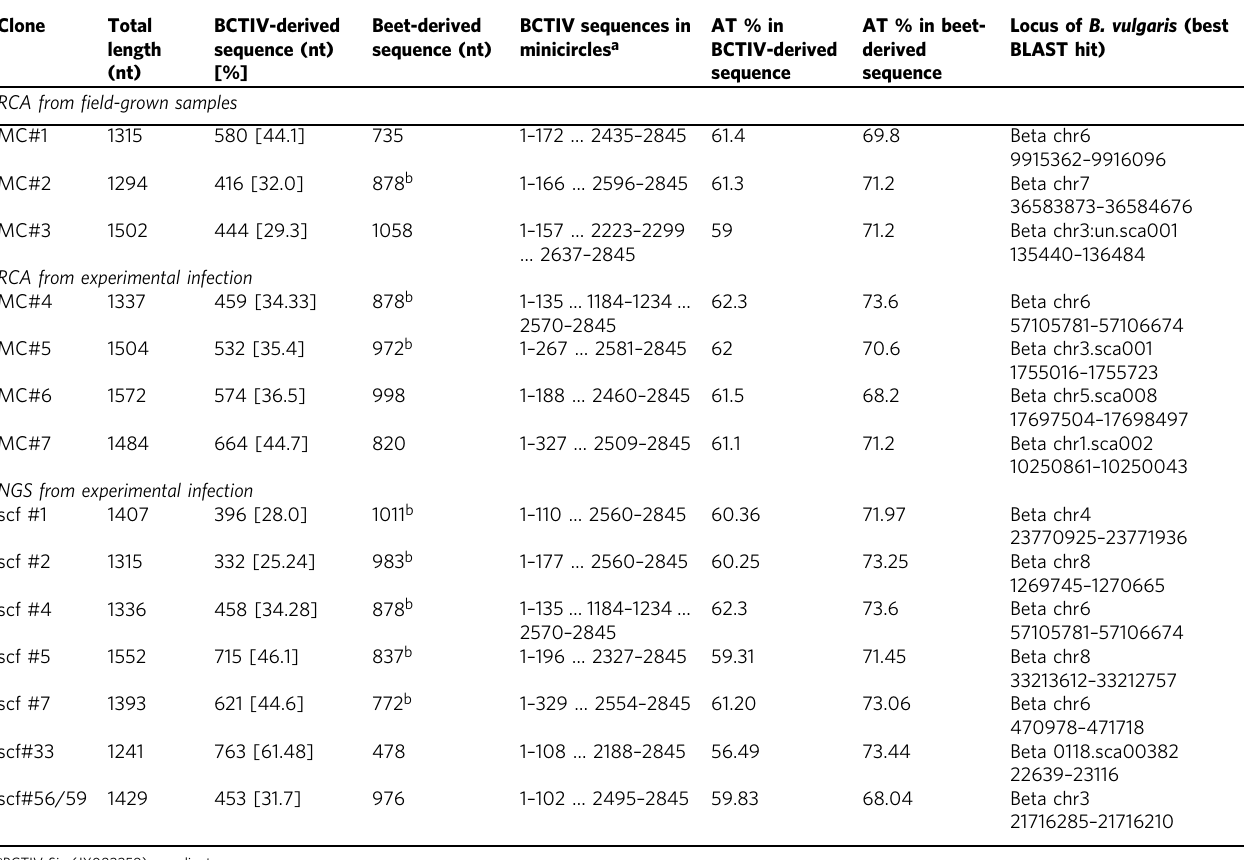
Table 1 Features of the minicircles cloned after RCA or identi fi ed by NGS from B. vulgaris (beet) plants infected by